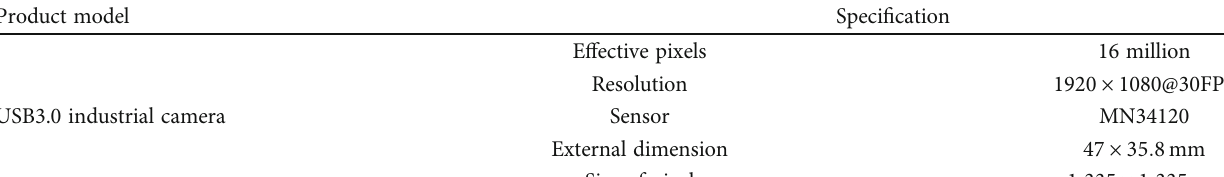
Table 1: The industrial camera parameters.